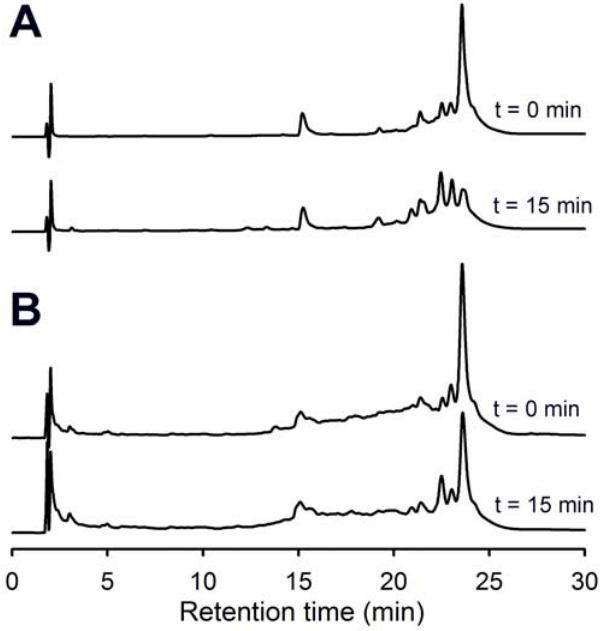
Figure 1. Digestion of the proteolytically resistant 33-mer peptide from a 2-gliadin with aspergillopepsin (ASP). (A) Reverse-phase HPLC traces of the 33-mer peptide incubated with ASP in a 20:1 (w/w) peptide:enzyme ratio at pH 4.5. (B) Reverse-phase HPLC traces of the 33-mer peptide mixed with gluten digested by pepsin, and incubated with ASP in a 20:80:1 (w/w/w) peptide:gluten:enzyme ratio at pH 4.5. The ordinate scale is identical in all traces. The peak at 15 min corresponds to an internal standard